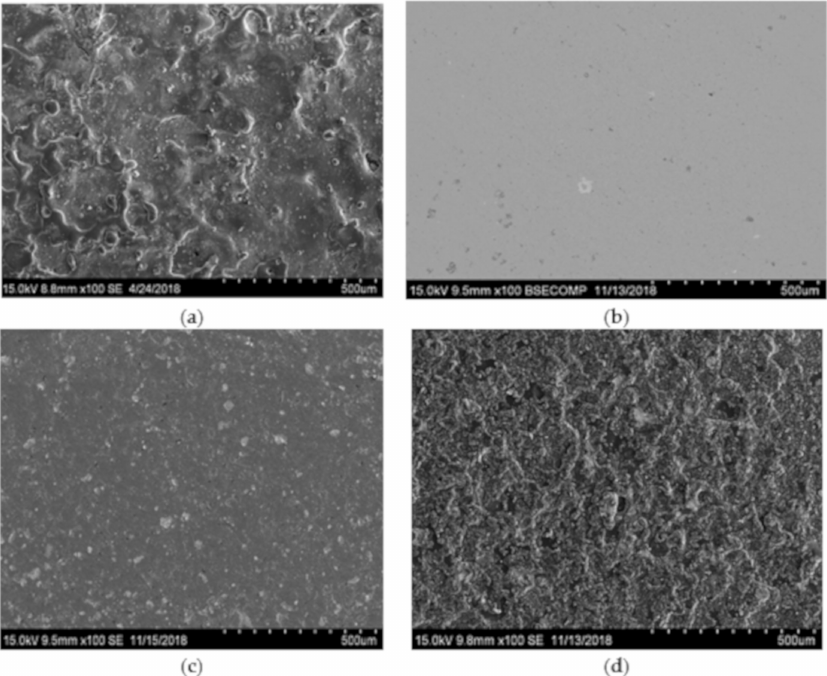
Figure 2. Scanning electron microscopy (SEM) top-view images of the coating surface: VESA ( a ), PCAE in Ar ( b ), PCAE in C 2 H 4 ( c ), and VESA–PCAE ( d ).